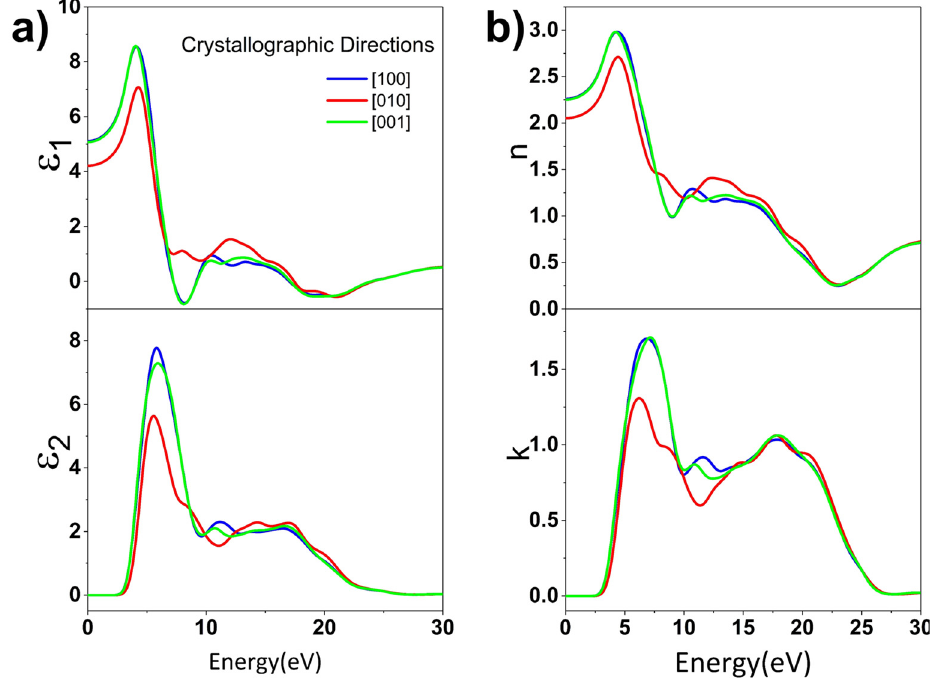
Figure 9. ( a ) Calculated real ( ε 1 ) and imaginary ( ε 2 ) parts of the dielectric function of LiAl(IO 3 ) 4 as a function of the incident photon energy and ( b ) corresponding real ( n ) and imaginary ( k ) parts of the refractive indexes. The line color is indicated for each crystallographic direction. These calculations have been performed with the PBE + scissor method.